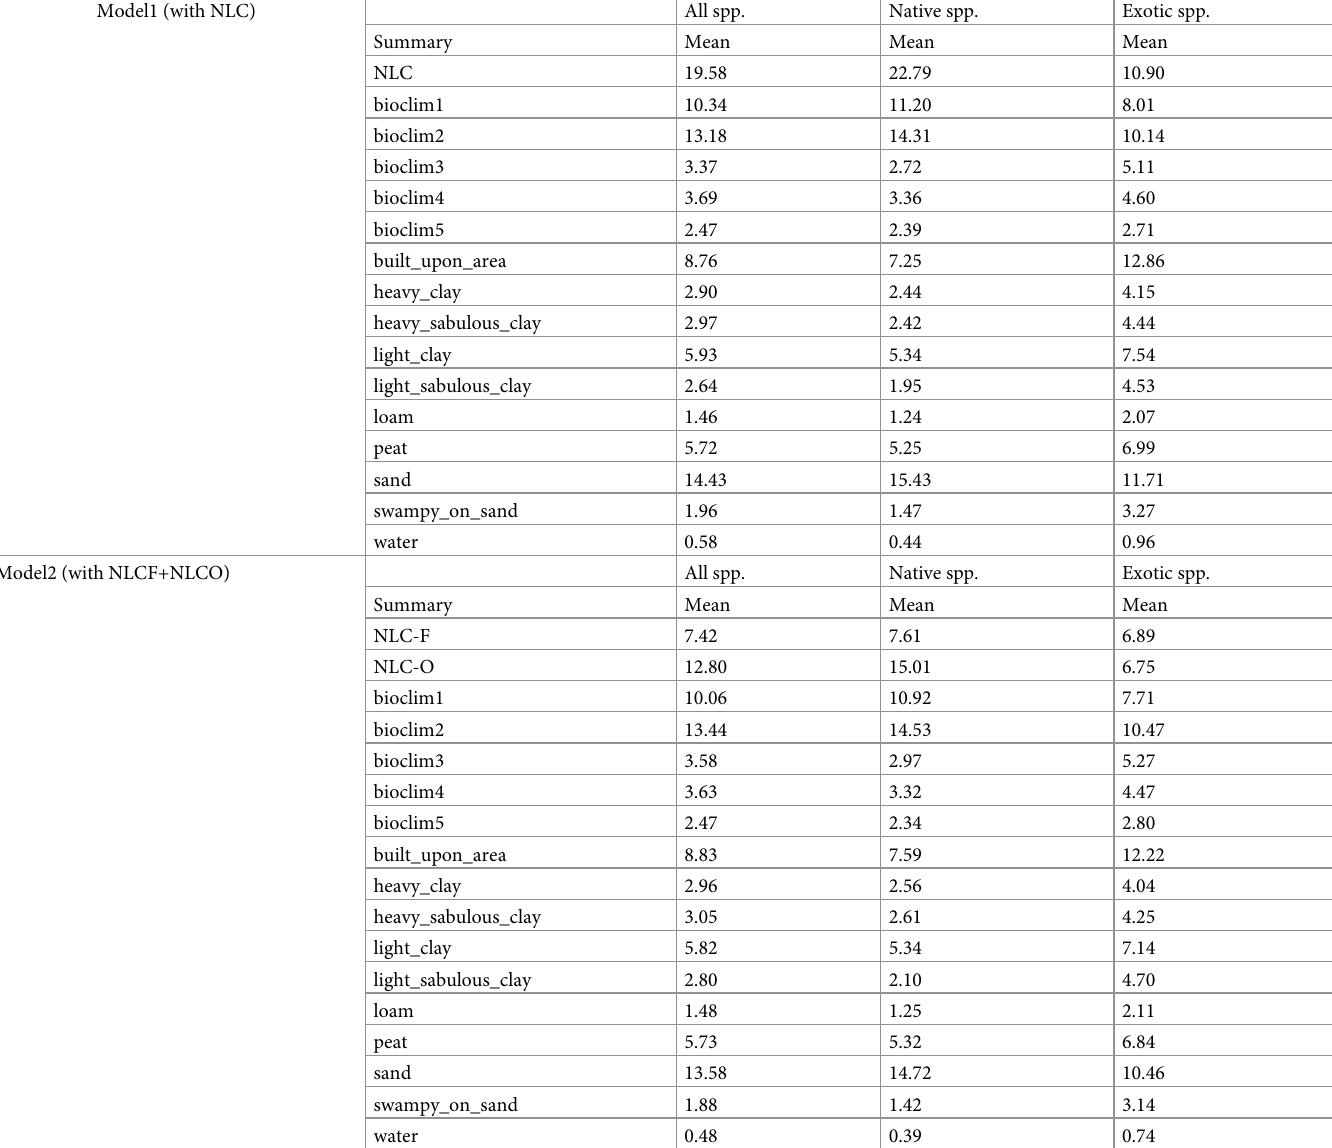
Table 1. Comparison of permutation importance among variables. Model1 (with NLC) All spp. Native spp.